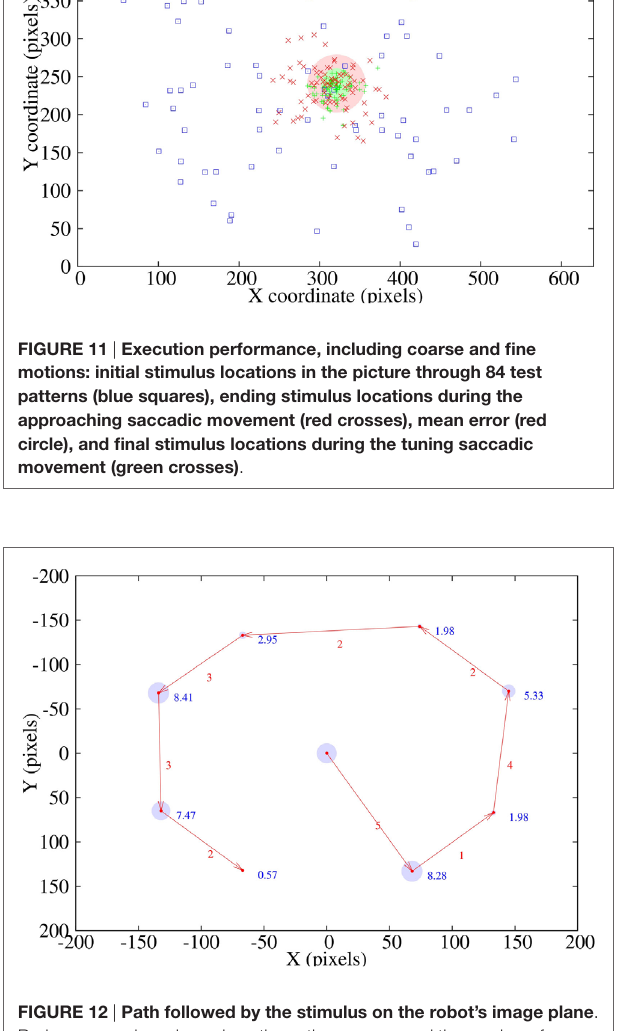
FigUre 12 | Path followed by the stimulus on the robot’s image plane . Red arrows and numbers show the path sequence and the number of saccadic movements in each centering task. Blue circles and numbers depict the error in pixels after centering the stimulus.